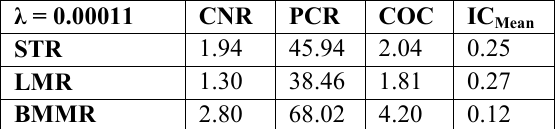
Fig.7: Conductivity reconstruction of the phantom with inhomogeneity (D = 30 mm, L = 37.5 mm) near electrode No.-3 (λ = 0.00011): (a) original object, (b) image with STR, (c) image Table-3: CNR, PCR and COC of the conductivity images of Fig. -7 λ = 0.0001